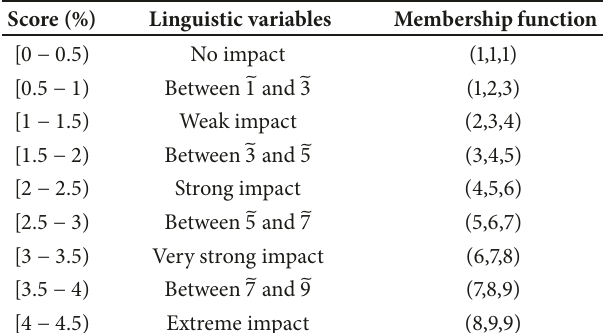
Table 2: Carbon emissions factor in kilograms per tonne kilometer. Table 3: Unemployment comparison scores.